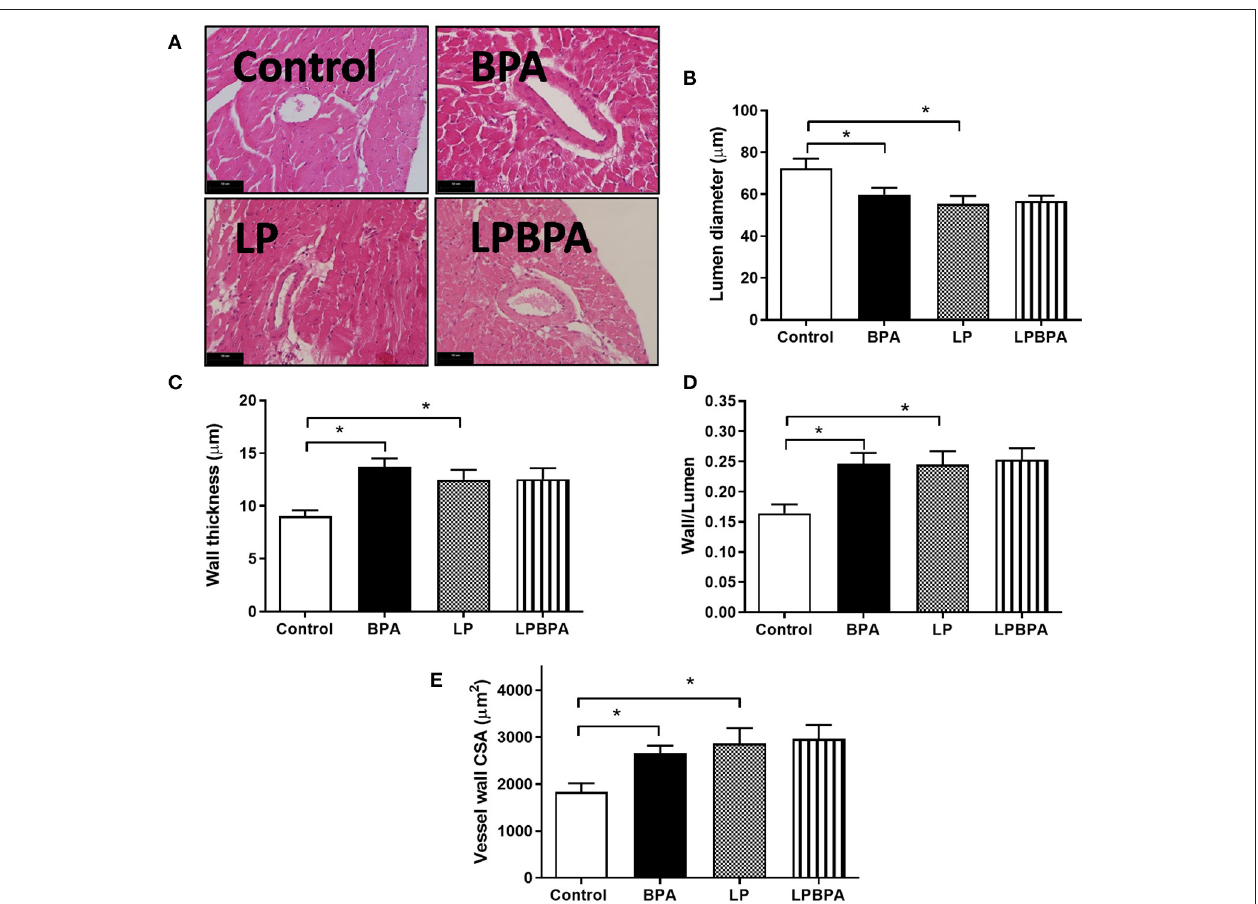
FIGURE 3 | Intramyocardial arterial remodeling following bisphenol A (BPA) and low-protein (LP) diet. Representative images for H.E. ( A , bars = 50 µ m) and quantified lumen diameter (B) , wall thickness (C) , wall/lumen ratio (D) , and wall cross-sectional area (CSA, E ) of intramyocardial coronary vessels in mice fed normoprotein (control) or LP diet during 8 weeks and exposed to BPA for 9 days. Data are expressed as the mean ± SEM (number of animals/group: control = 10; BPA = 9; LP = 6; LPBPA = 6). One-way ANOVA followed by the Newman-Keuls test; * p < 0.05 vs.